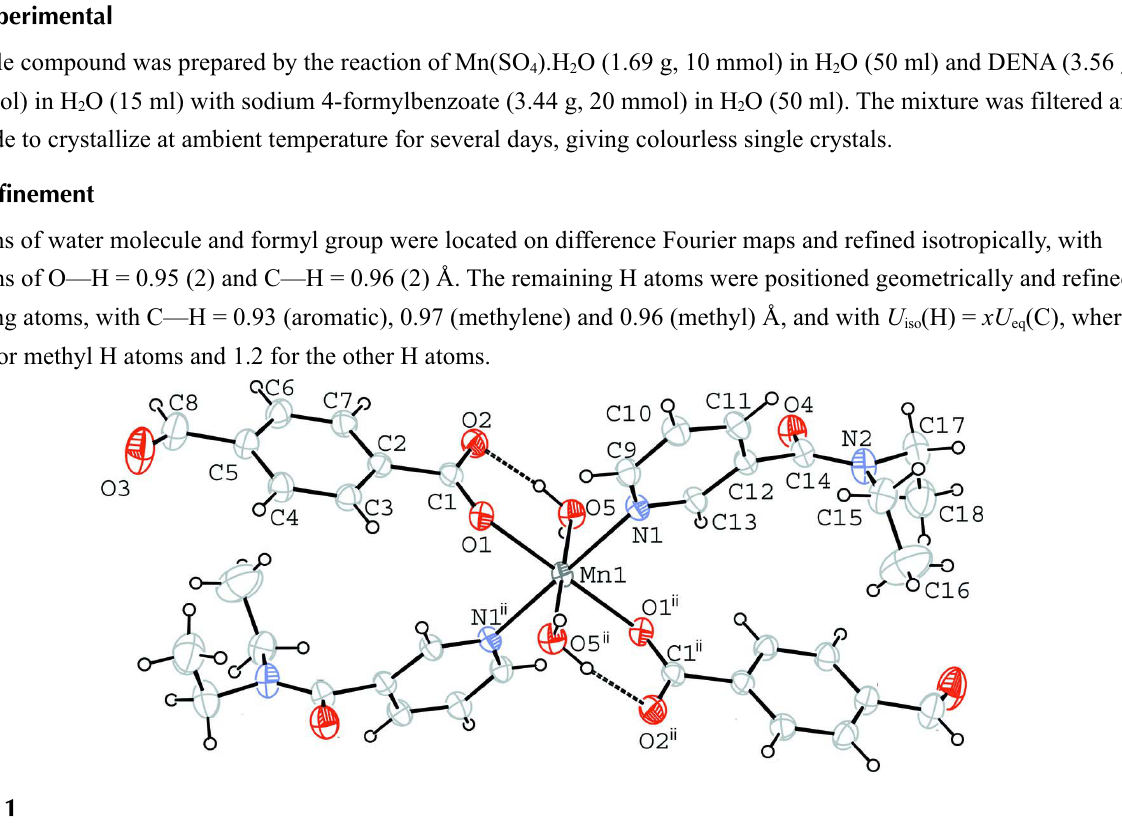
The molecular structure of the title compound. Displacement ellipsoids are drawn at the 40% probability level. Hydrogen bonds are shown as dashed lines. [Symmetry code: (ii) 1 - x , 1 - y , 1 - z